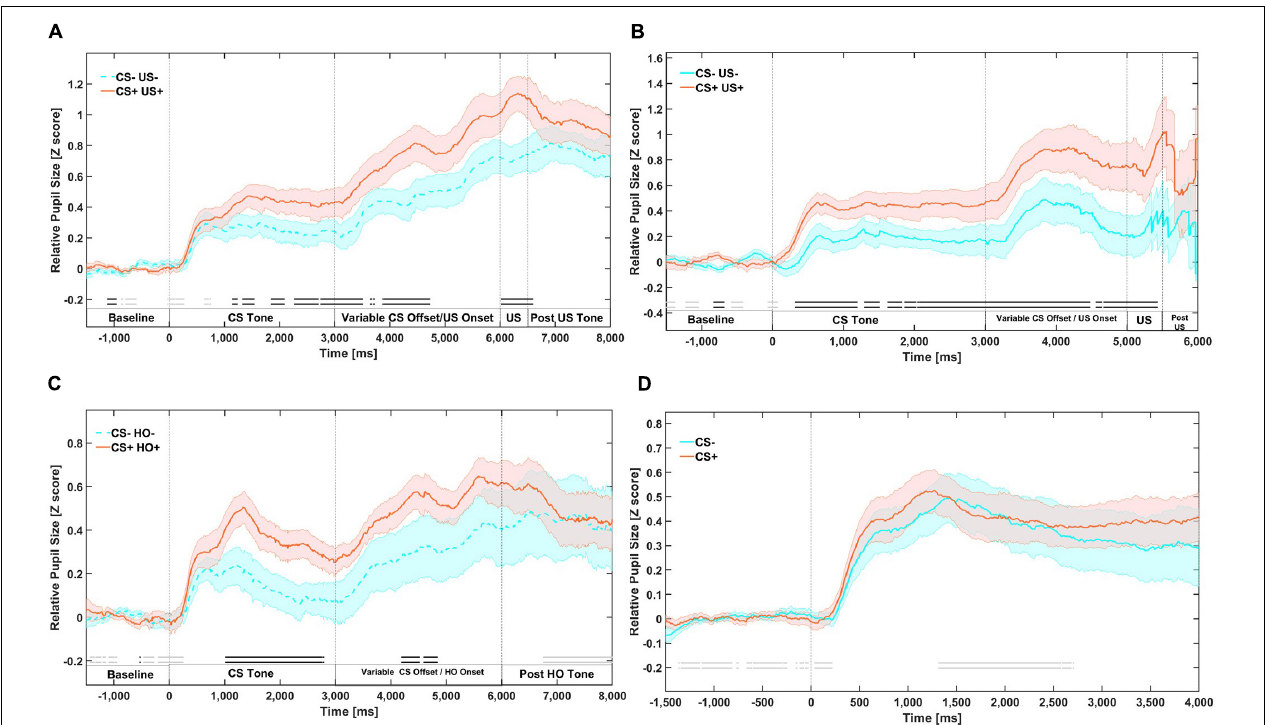
FIGURE 1 | Mean relative pupil dilation ( z -score) responses during first order tones in four different phases. (A) Phase 1: First-order conditioning on day 1. (B) Phase 2: First-order reminders on day 2. (C) Phase 3: Higher-order conditioning. First-order stimuli are paired with higher-order stimuli. (D) Phase 4: First-order testing. First-order stimuli presented alone. Meaningful differences (BF10 ≥ 3) are indicated by an opaque double line along the X axis of each panel of the figure, above the segment labels. Evidence in favor of the null hypothesis is indicated by faded double line along the X axis of each panel of the figure. The dark line in color represents the mean of that condition (orange for CS+/US+ trials and blue for CS–/US– trials). The lighter color bands surrounding the darker colored lines represent Standard Error of the